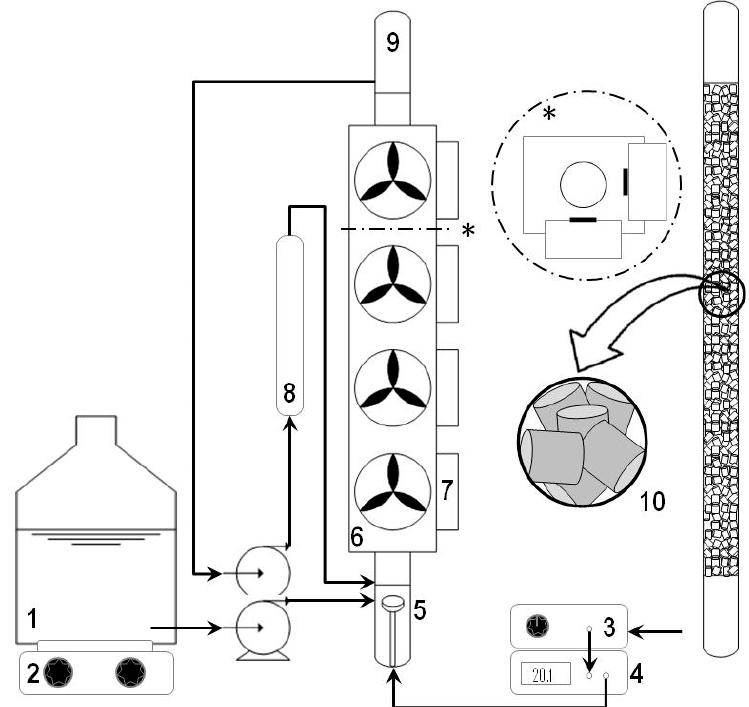
Figure 7. Scheme of the experimental set-up used for continuous operation. 1: reservoir, 2: magnetic stirrer 3: ozone generator, 4: ozone analyzer; 5: ceramic diffuser, 6: box of LEDs, 7: fan, 8: loop column, 9: packed column, and 10: glass coated or uncoated rings. * Cross section of the system. Adapted from